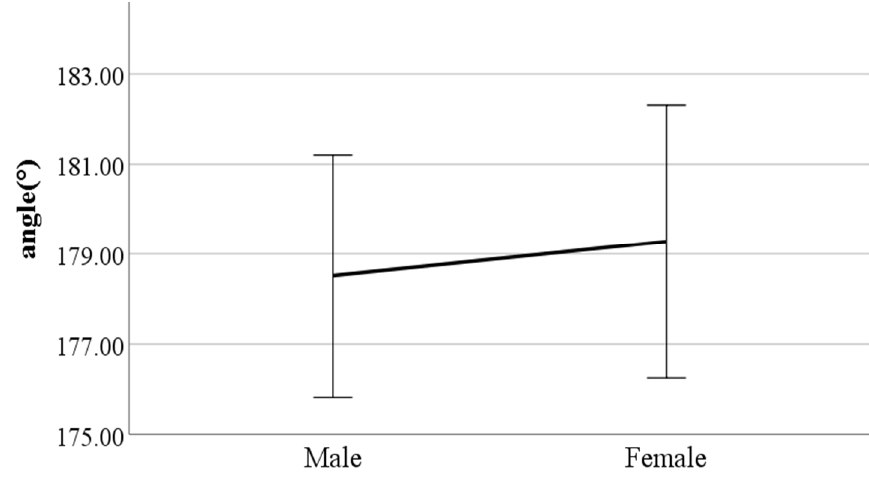
Figure 19. Gender difference in shoulder angle in the frontal plane at the double support phase (left foot forward) (F value: 4.72, DF: 289, p -value: 0.00).